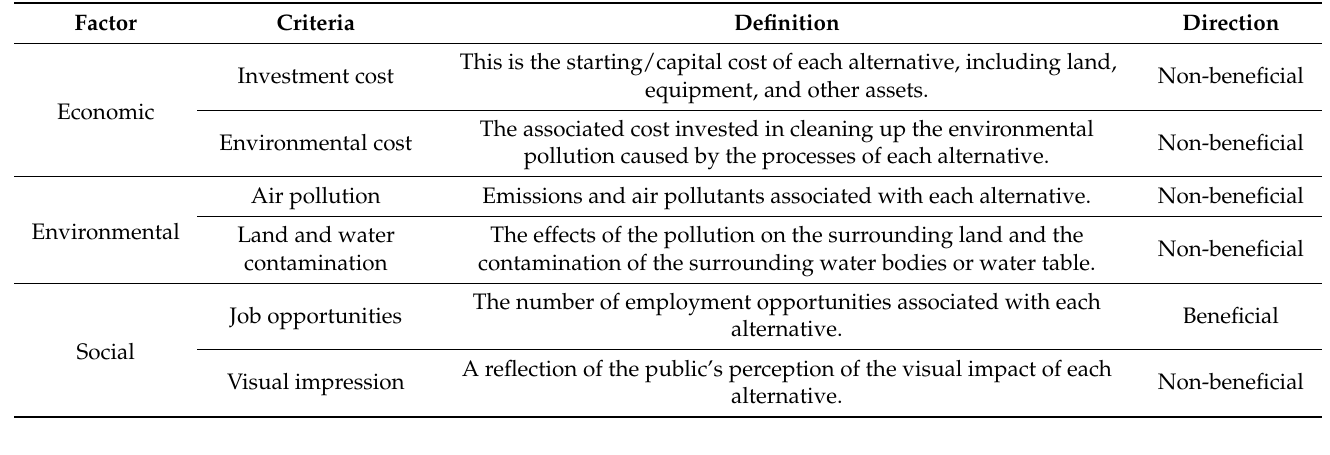
Table 3. The battery disposal strategies.